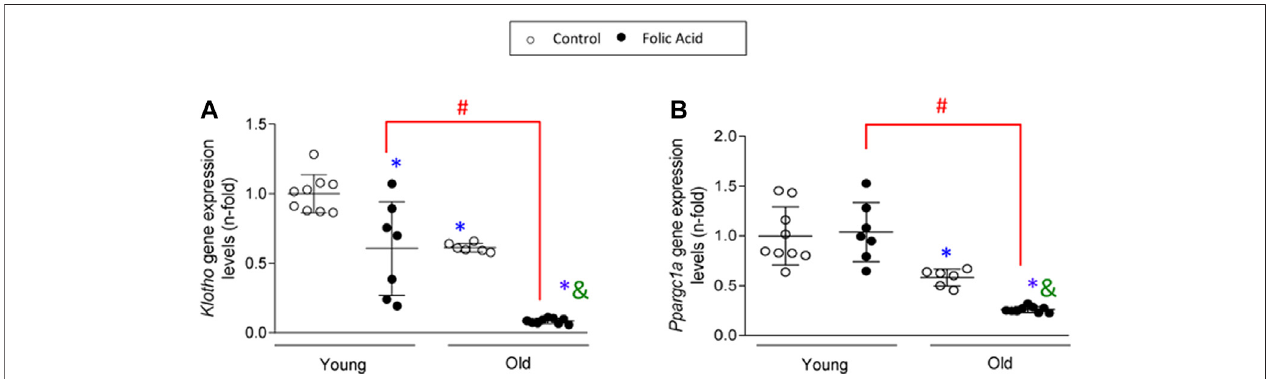
FIGURE 9 | Loss of protective factors in old kidneys is exacerbated in response to folic-acid (FA) administration. Folic Acid (FA; 125 mg/kg) was injected in 3- months-old(Young)and1-year-old(Old)C57BL/6miceandkidneyswerestudiedafter48 h.Kidney Klotho (A) and Ppargc1a (B) geneexpressionlevelswereassessed by qRT-PCR. Data are shown as n-fold and expressed as mean ± SD of n (cid:2) 6-9 animals per group. * p < 0.05 vs. control young mice, # p < 0.05 vs. FA-injected young mice, & p < 0.05 vs. control old mice. The parametric one-way ANOVA statistical test was performed.